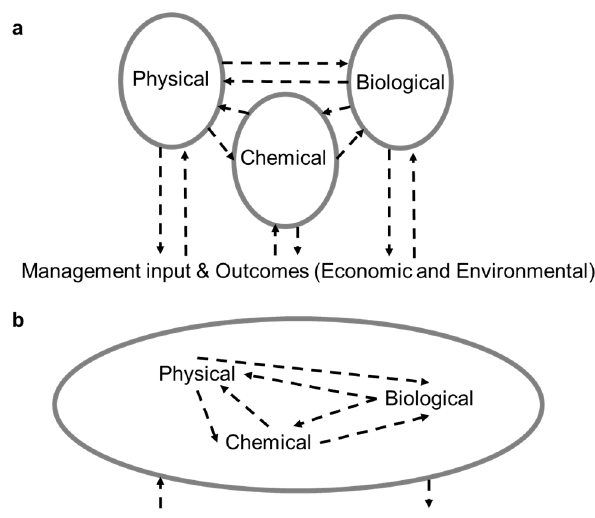
Figure 1. Perspectives often used in understanding soil processes and functions: ( a ) currently “siloed” and fragmented nature of soil disciplines (solid gray boundaries) with weak coupling between soil system components, with individual (potentially contradicting) considerations of management inputs and environmental outcomes; ( b ) systemic boundary condition which includes strong coupling between soil system components with integrated considerations for management inputs to the whole system and environmental outcomes.